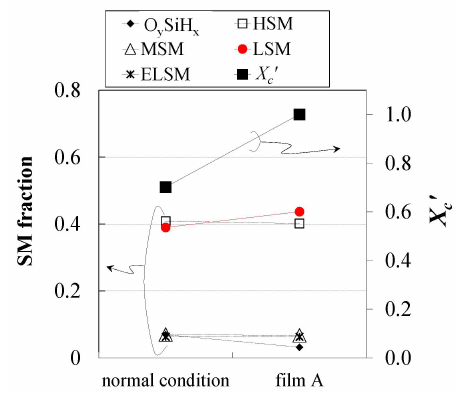
Figure 6. Analyzed results of film tests, normal-condition film and film A, by Raman spectrometry and FTIR. The values of X c 1 were normalized by the value of the film